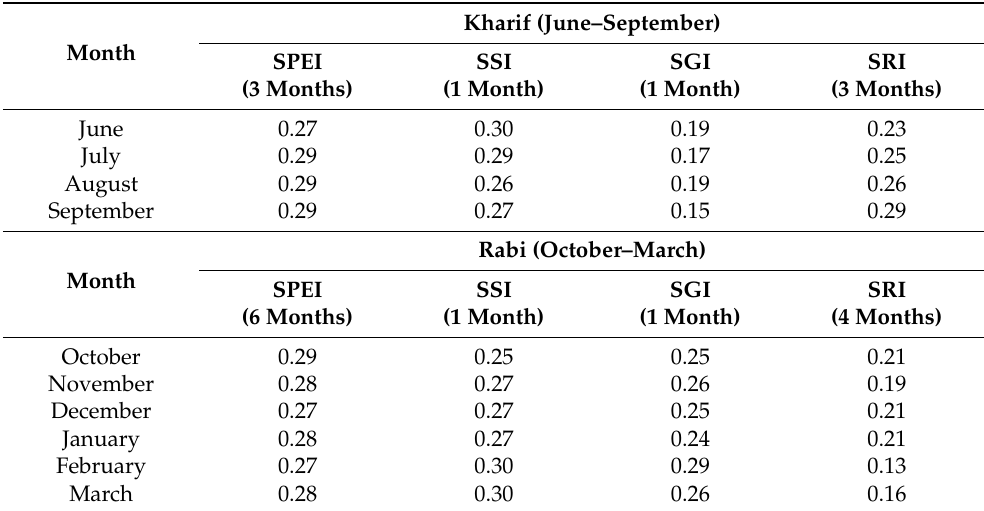
Table 2. Weights of indices for JDI_PCA_3_1_1_3 for Kharif and JDI_PCA_6_1_1_4 for Rabi season over Marathwada.